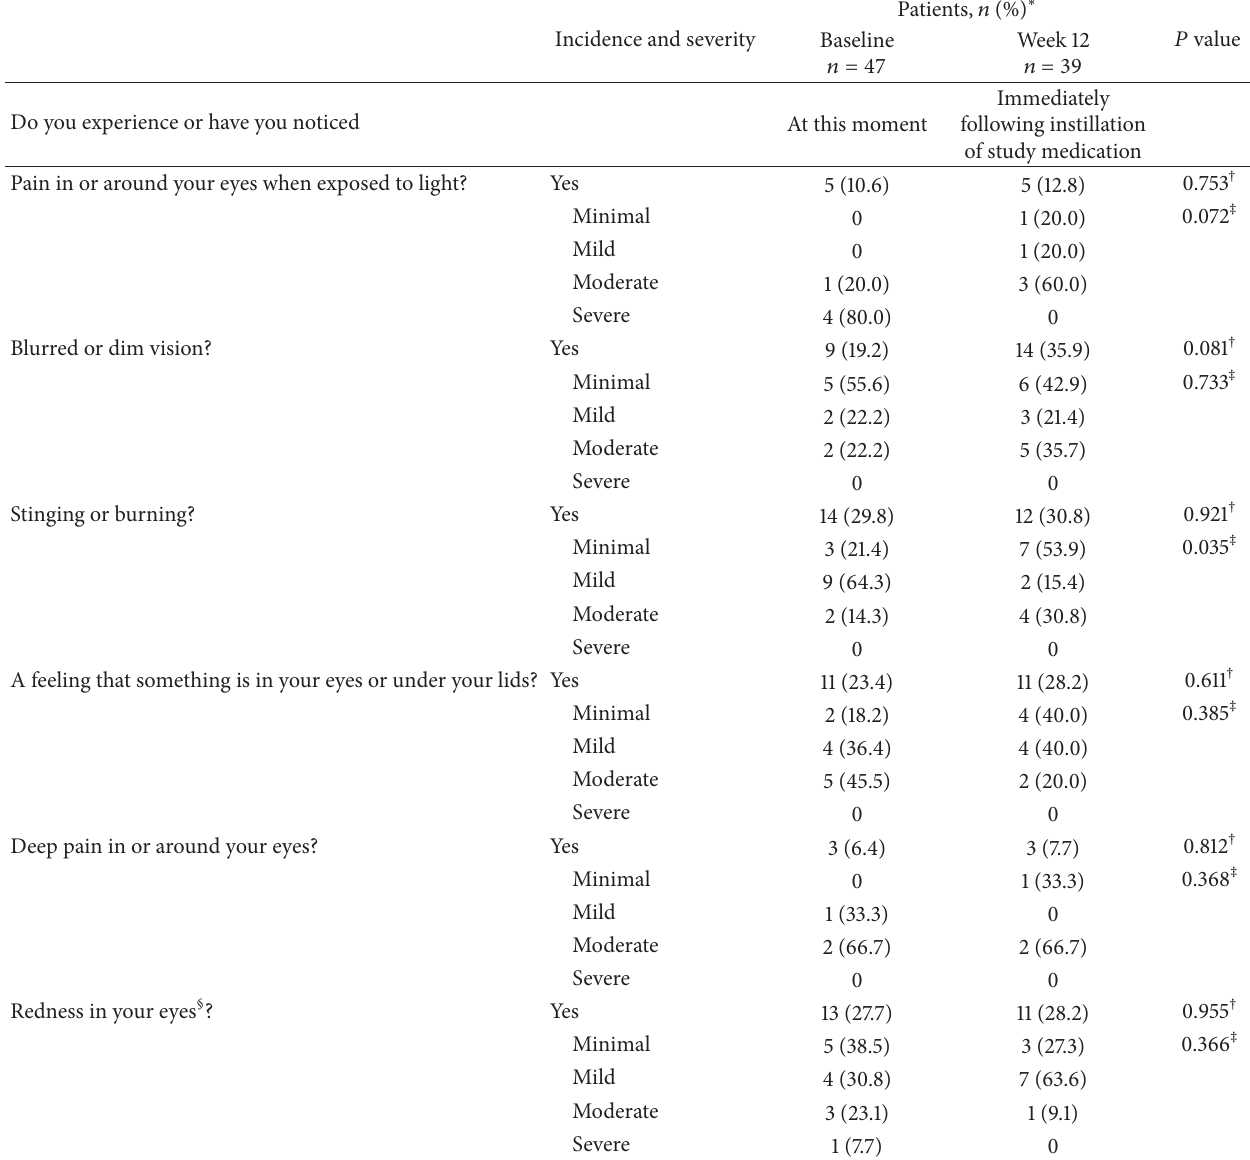
Table 1: Patient experience survey